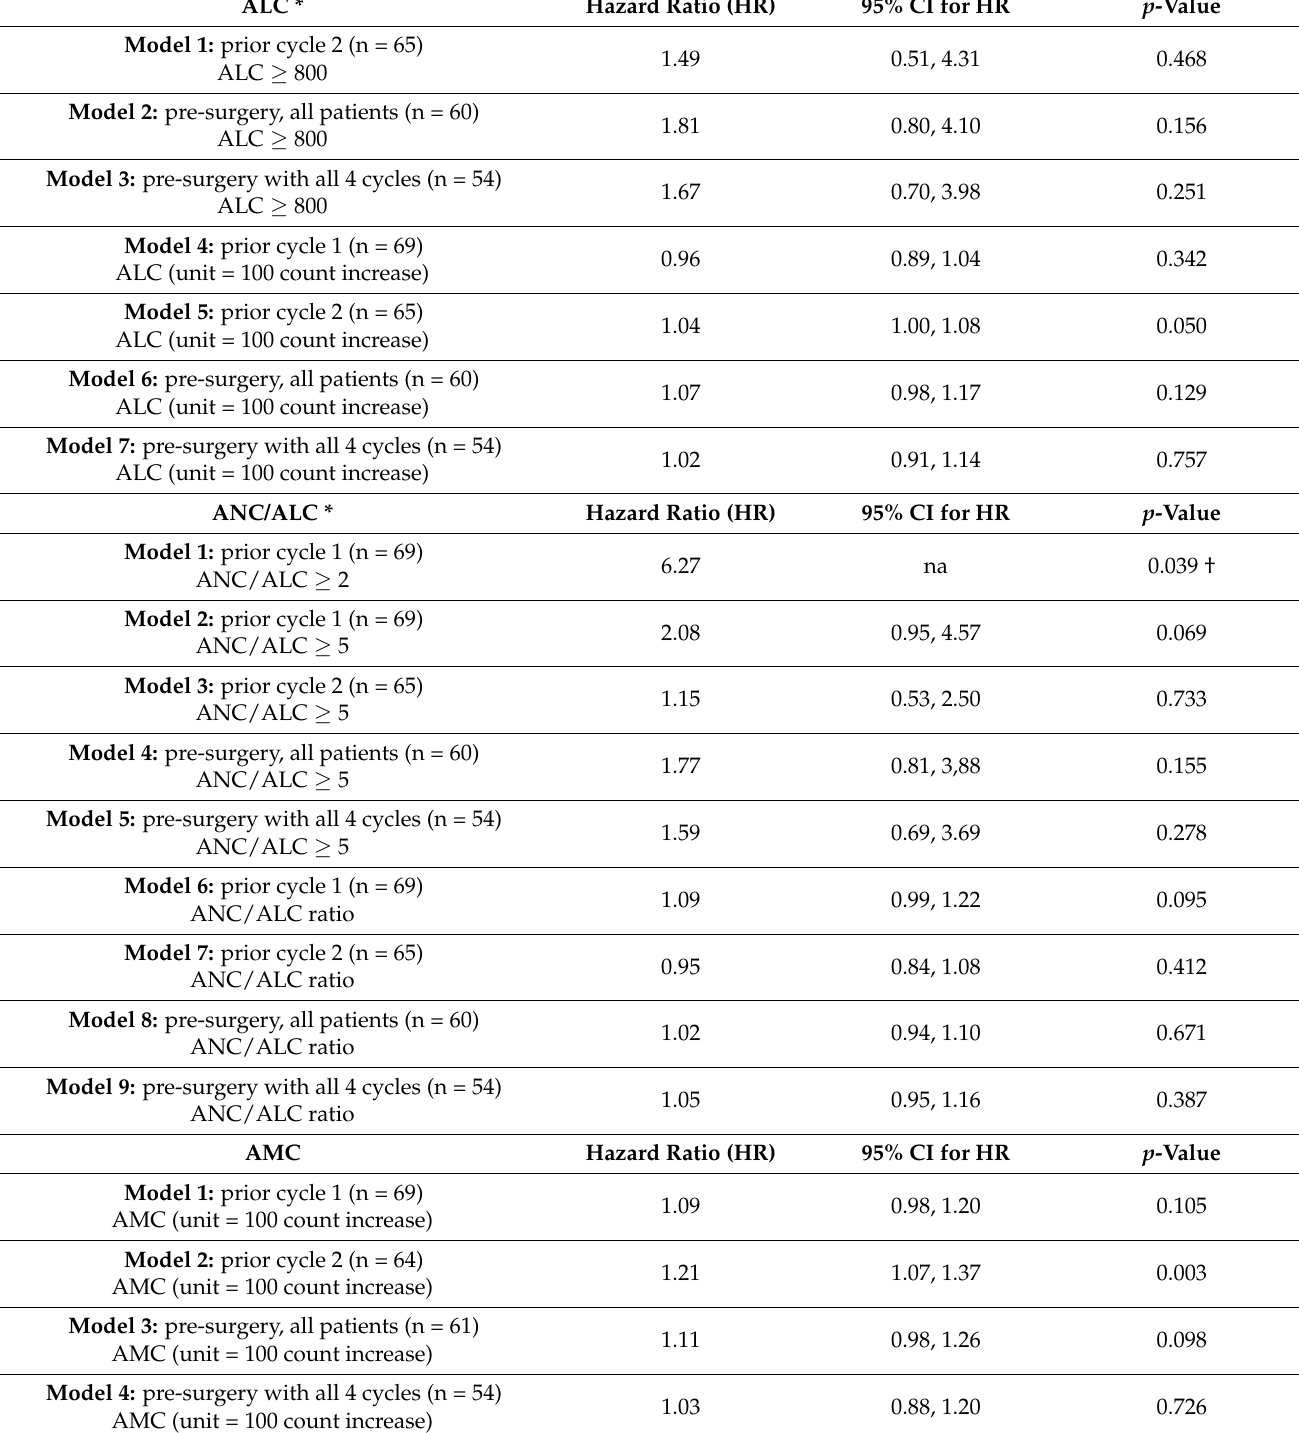
Table 3. Survival analysis of OS by various cell count values at different times using Cox